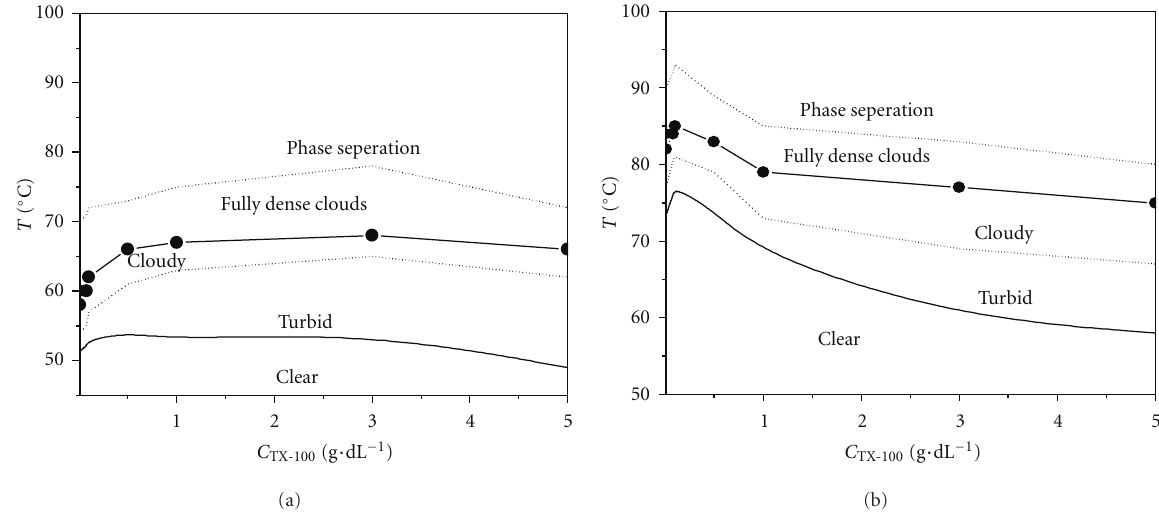
Figure 1: Dilute aqueous solution phase diagram for block copolymers-TX-100 mixtures: (a) B-1–TX-100 and (b)